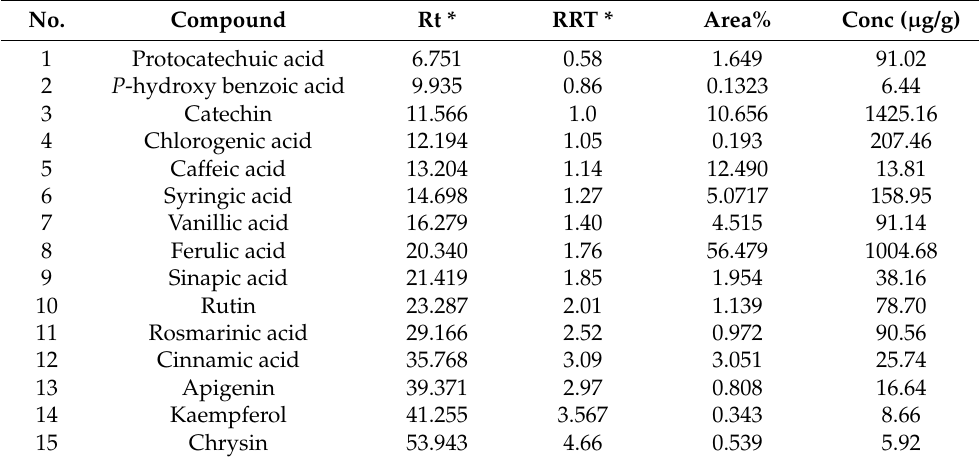
Figure 2. HPLC chromatogram of phenolic compounds of C. diurnum leaves extract. Table 1. Phenolic compounds of C. diurnum L. leaf parts identified by